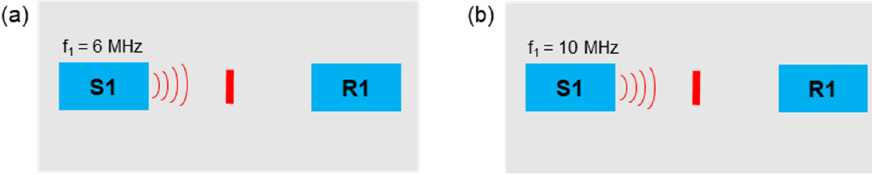
Figure 10. Excitation frequencies: ( a ) f 1 = 6 MHz; ( b ) f 1 = 10 MHz.